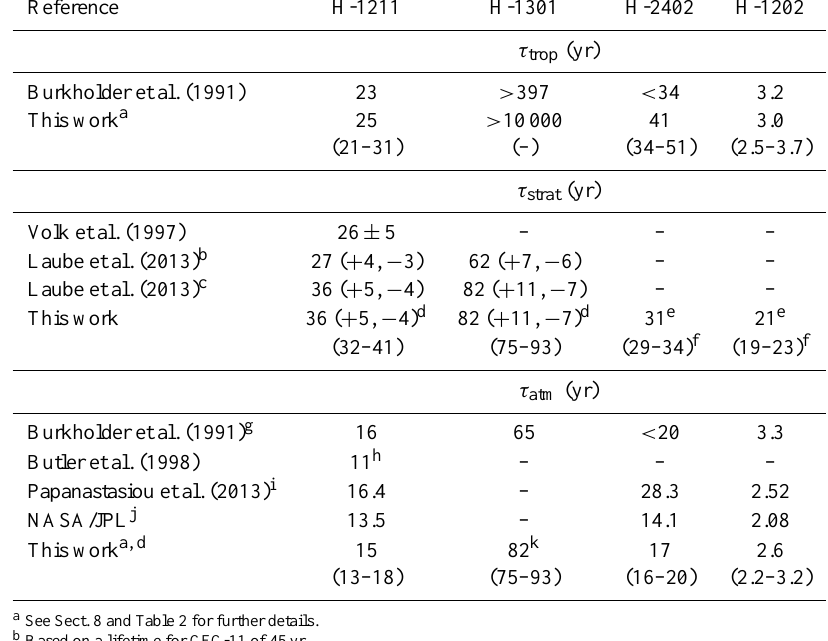
Table 4. Tropospheric ( τ trop ), stratospheric ( τ strat ), and total atmospheric ( τ atm ) lifetimes of the halons reported in the literature and calculated in this